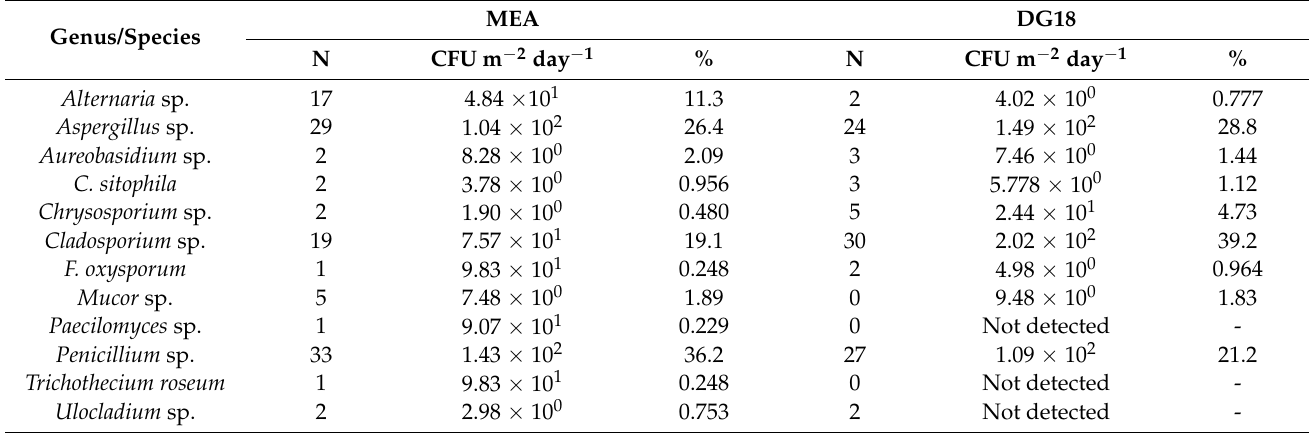
Table 2. Distribution of fungal species in both culture media applied.